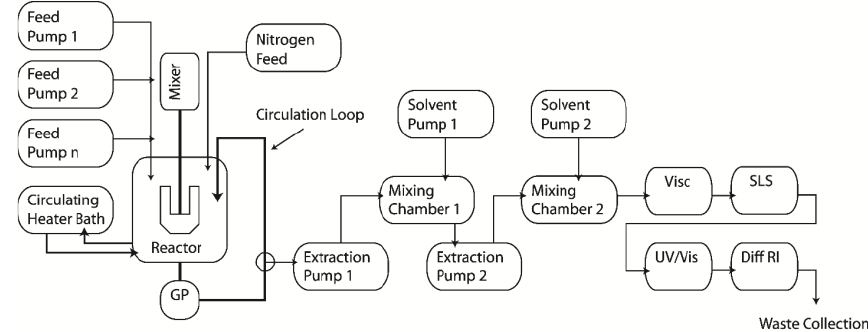
Figure 3. Automatic continuous on-line monitoring of polymerization setup for the monitoring of methyl methacrylate solution polymerization used in this work.